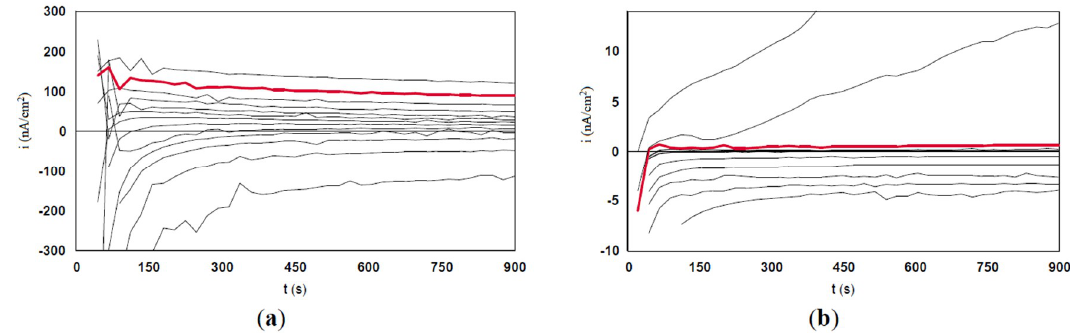
Figure 9. Potentiostatic scan curves for #2 and #11steels evaluated for crevice-pitting corrosion.( a ) #2- 317LM* 20-19-4; ( b ) #11-904L*** 20-25-5 Cu. 317LM* 20-19-4; ( b ) #11-904L*** 20-25-5